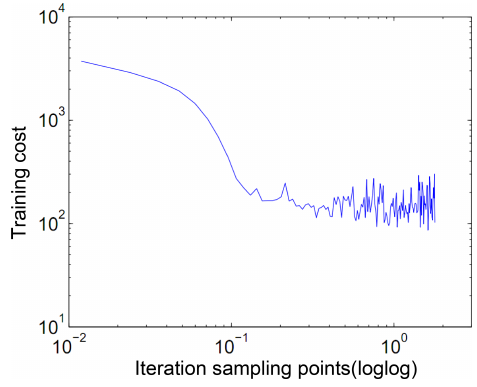
Figure 6. Iteration sampling points.